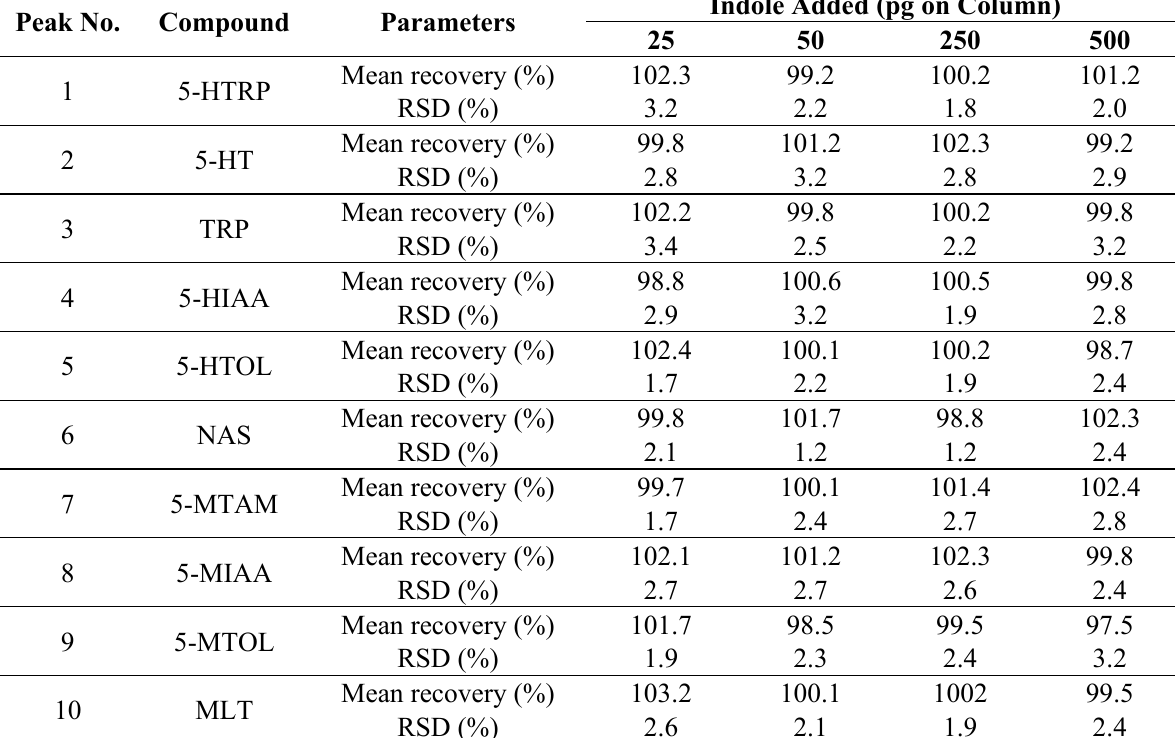
Table 2. Recovery of indoles added to the pineal homogenate in the assay using HPLC with fluorescence detection. Five pineal organs were sonicated in 500 µL of perchloric acid and centrifuged at 1000× g for 5 min, and the supernatant was divided into portions. The solutions containing indoles at concentrations corresponding to 0, 25, 50, 250 and 500 pg on the column were added to these portions. Next, the samples were assayed as described in the ―Experimental Secti on‖. The test was repeated three times. Peak